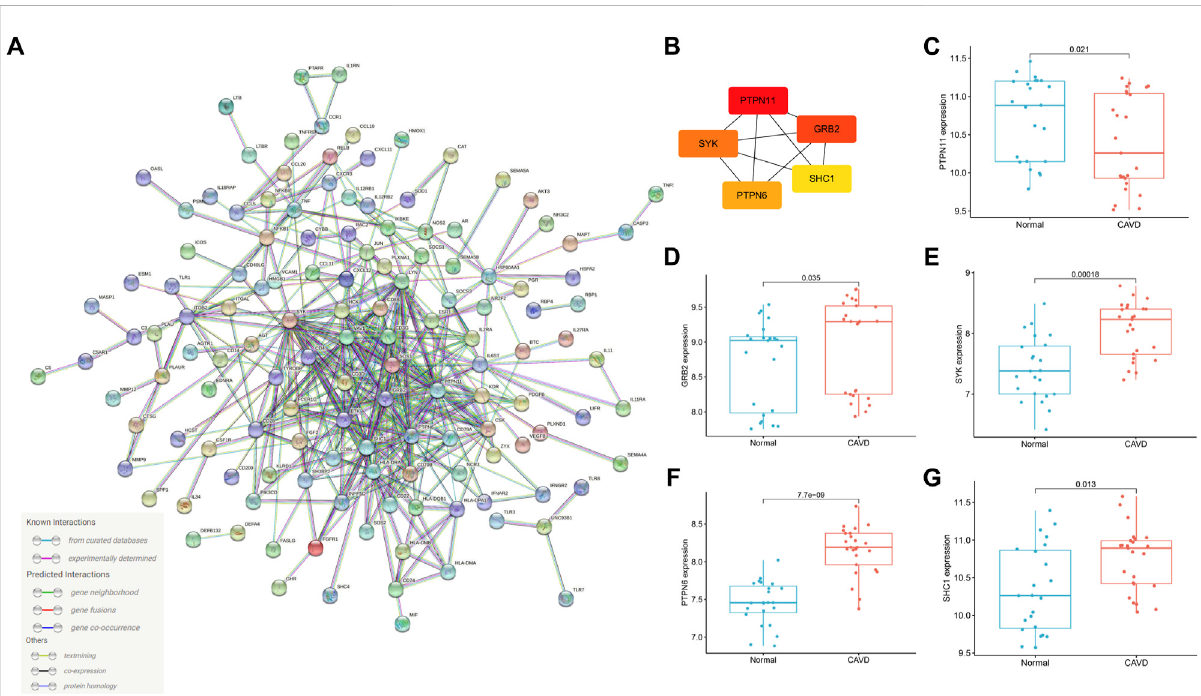
FIGURE 6 PPI network and identi fi cation of hub genes. (A) PPI network of DEIRGs in CAVD created by STRING website. The number of edges between different proteins represents the number of evidences supporting the interaction relationship in STRING database. (B) Top 5 hub genes identi fi ed by “ cytoHubba ” according to mixed character calculation and its core network. The essentiality of hub genes increases from yellow to red. (C – G) The expression of PTPN11, GRB2, SYK, PTPN6 and SHC1 in calci fi ed and normal aortic valve. PPI: protein-protein interaction; DEIRGs: differentially expressed immune related genes; CAVD, calci fi c aortic valve